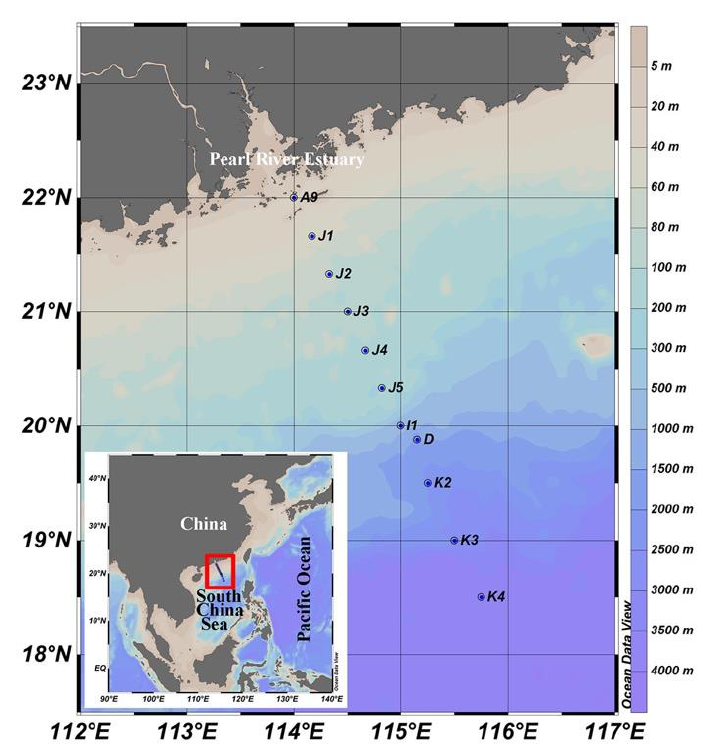
Figure 1. Geographic location of the sampling sites.